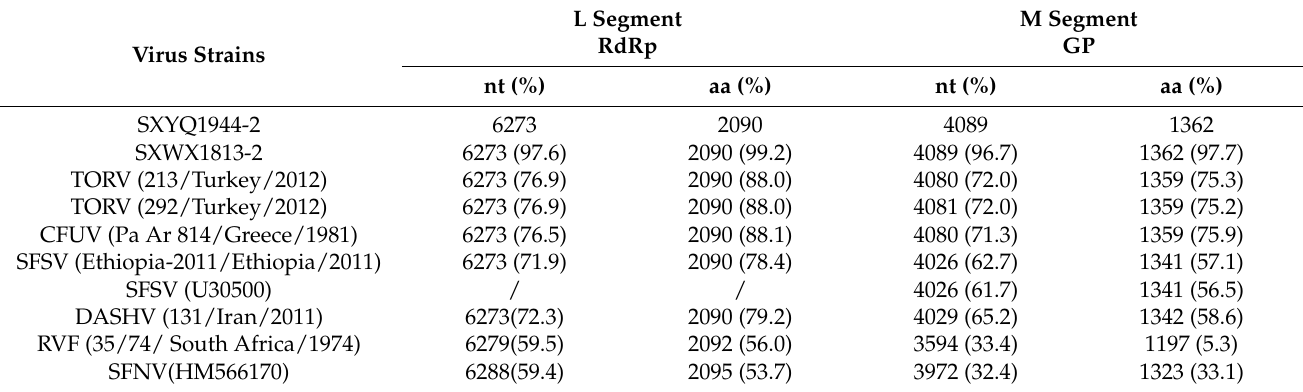
Table 3. Viral genome sequence